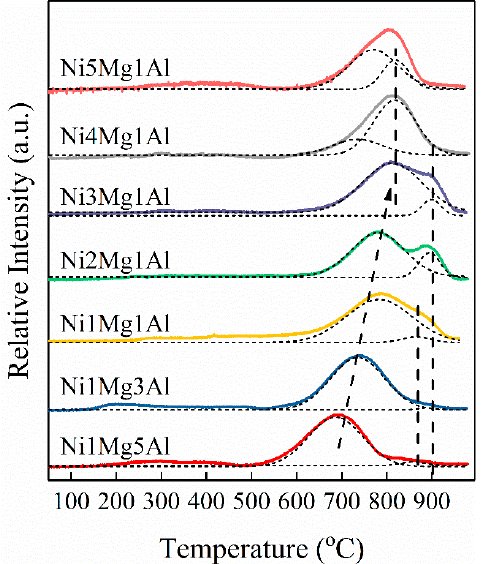
Figure 2. H 2 -TPR profiles of calcined Ni x Mg y Al samples.